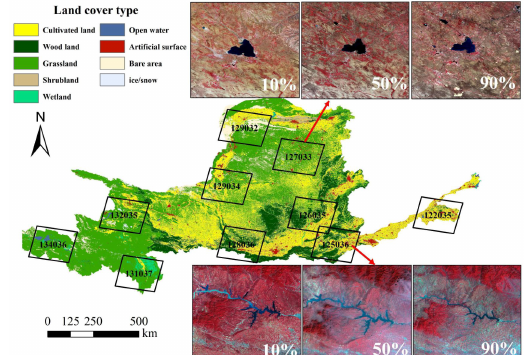
Figure 3. Spatial distribution of sampled tiles and composite images of the three percentiles (10%, 50%, and 90%) (false color shows RGB: NIR, Red, Green). The numbers in the sampled plots indicate the paths (first three digits) and rows (last three digits) of Landsat WRS-2. The land cover type data are from GlobalLand30.